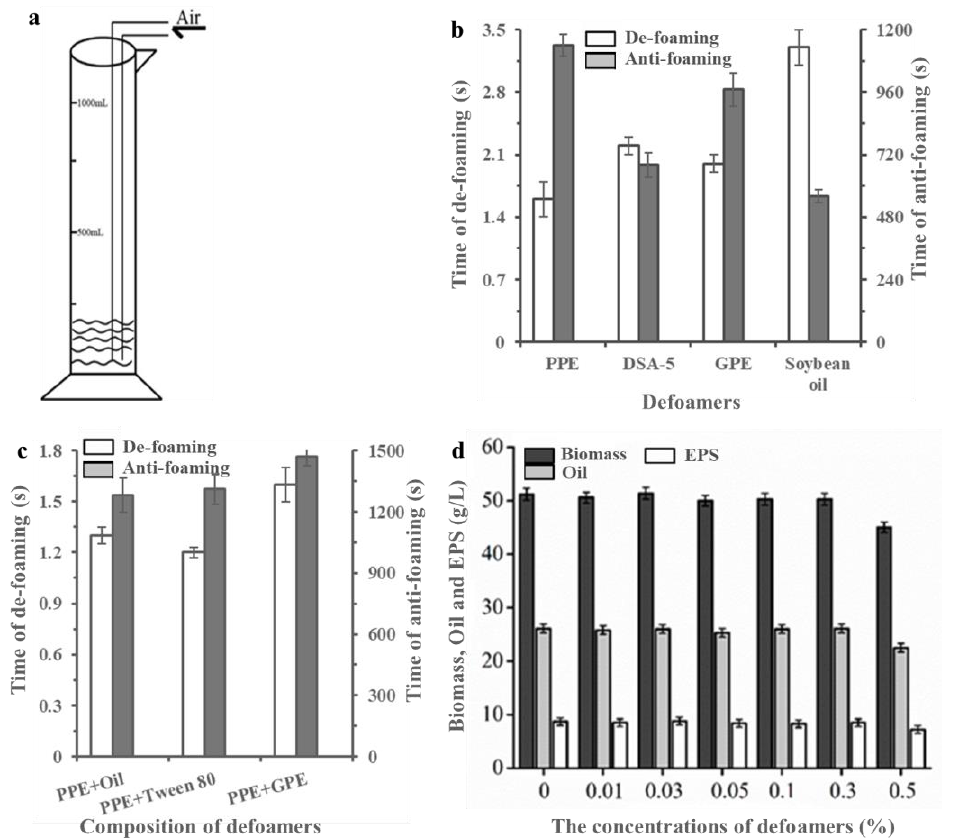
Figure 1. The effects of defoamers on defoaming, antifoaming and fermentation performance of S. pararoseus JD-2. ( a ) Simple foam forming device. ( b ) The antifoaming abilities of different defoaming:the DSA-5 represents the defoamer for bean products. ( c ) Effects of different synergistic methods on PPE defoaming ability ( d ) Effect of defoamer on S. pararoseus JD-2 fermentation. The data represent mean values and standard deviations obtained from three independent cultivations.